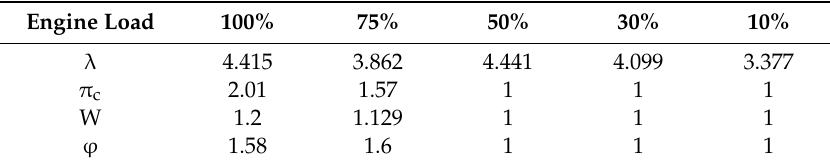
Table 2. The main parameters of Equation (2).